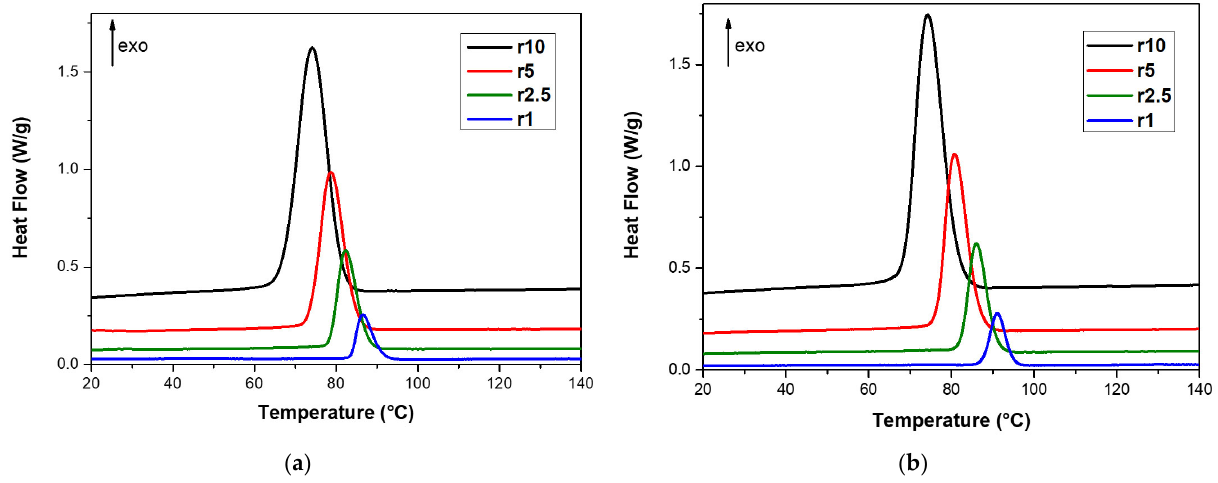
Figure 4. DSC cooling curves of ( a ) neat PBSu and ( b ) PBSu/5% biochar at cooling rates from 1 to 10 °C/min. Table 2. The crystallization temperature, T c , and the crystallization enthalpy, ∆ H c , of PBSu/biochar composites under non-isothermal crystallization.